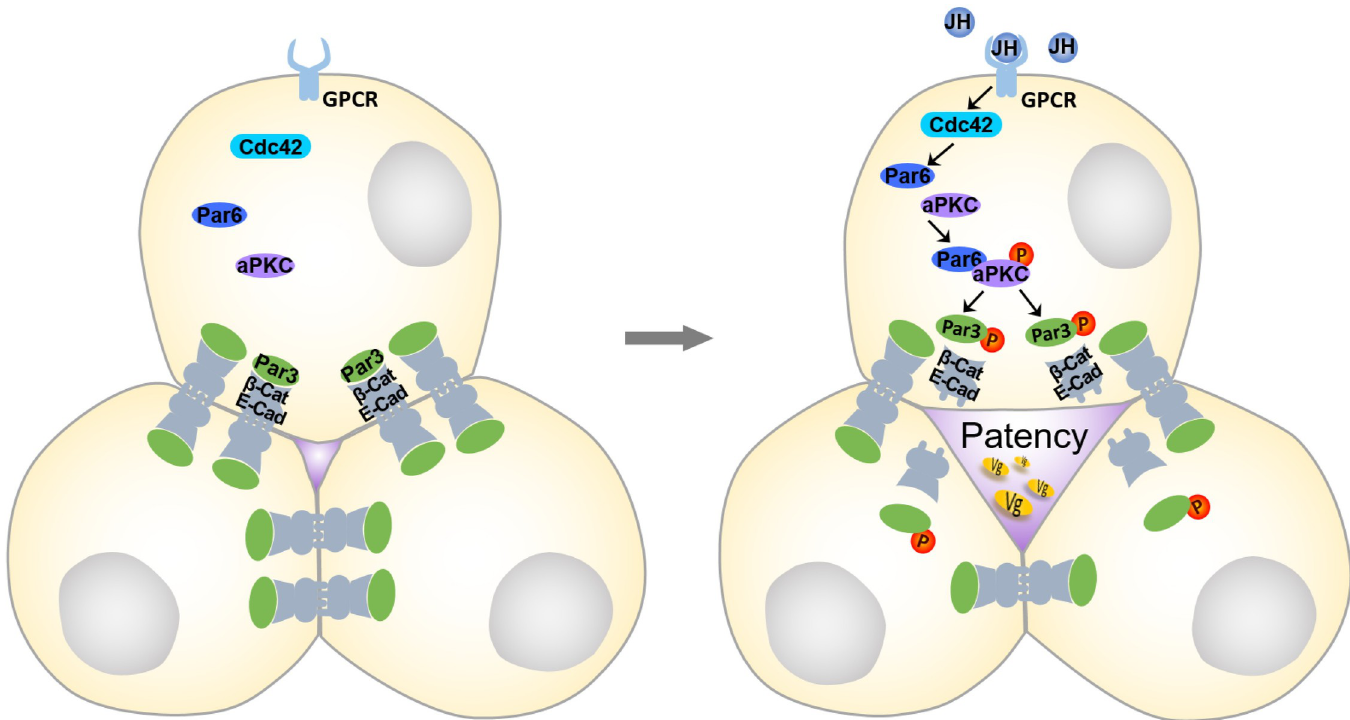
Fig 7. A proposed model for JH-stimulated ZA disassembly and vitellogenin transport in the follicular epithelium. JH promotes Par3 phosphorylation via a signaling cascade including GPCR, Cdc42, Par6 and aPKC. Phosphorylated Par3 disassociates from E-Cad/ β -Cat complex, consequently causing ZA disassembly at tricellular vertices and patency opening. Patency allows yolk protein precursors to pass through the barrier of follicular epithelium and reach the surface of maturing